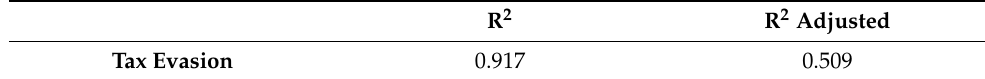
Table 5. Coefficient of determination, R 2 .